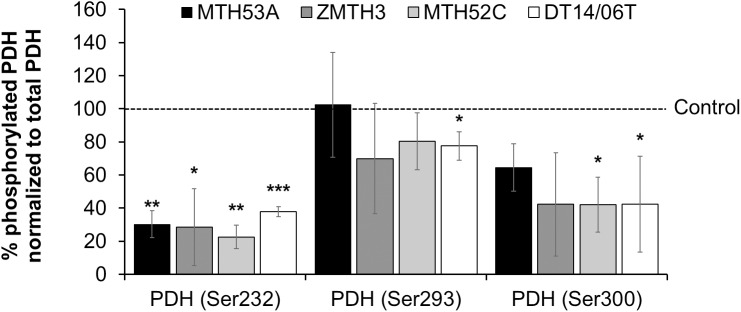
Effect of 10 mM DCA on PDH phosphorylation at three different residues after 48 hours treatment.Data was assessed with Luminex Magnetic Bead technology. PDH-P at Ser232 decreased significantly in all cell lines. Residue Ser293 showed no significant response to DCA treatment except in cell line DT14/06T. The third phosphorylation site Ser300 has decreased values in carcinoma cell lines but not in non-neoplastic mammary gland derived cell line MTH53A and benign cell line ZMTH3. Data are shown as mean ± SD, n≥3 and are presented as relative PDH-P values in comparison to untreated control (%). Control was set to 100%. Statistical analysis was performed with two-tailed t-test, *p<0.05, **p<0.01, ***p<0.001.